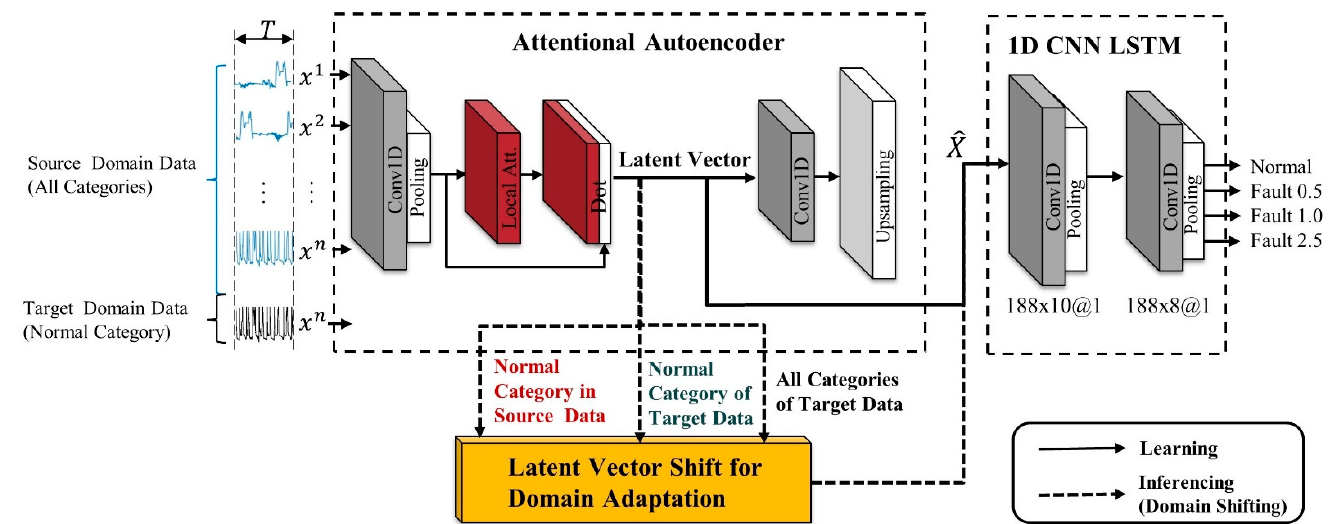
Figure 4. The architecture of the proposed model including a latent vector shifting algorithm.